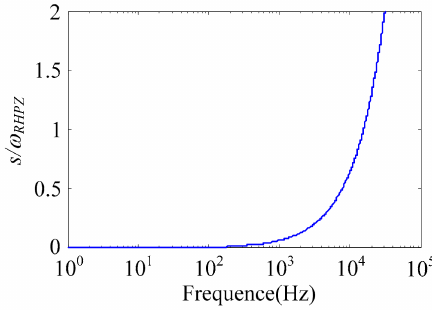
Figure 10. Magnitudes of s/ ω RHPZ as the functions of frequency.